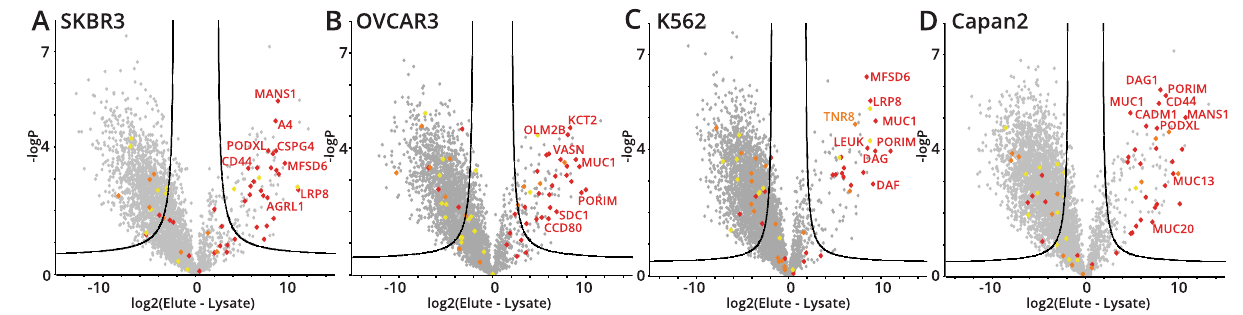
Fig. 3 Mucinome of cancer-associated cell lines. A – D Volcano plots representing four enrichment experiments from SKBR3 ( A ), OVCAR3 ( B ), K562 ( C ), and Capan2 ( D ) cell lines. Cell lysates were subjected to the work fl ow described in Figs. 1 and 2, scored with the mucin-domain candidacy algorithm, and mucin-domain glycoproteins were labeled according to the Mucin Score. Red signi fi ed a score of >2 (high con fi dence), orange 2 – 1.5 (medium con fi dence), and yellow 1.5 – 1.2 (low con fi dence). Strongly enriched proteins were labeled with their gene names associated with speci fi c proteins. Source data are in Supplementary Data 3. Signi fi cance testing was performed using a two-tailed t-test with 250 randomizations to correct for multiple comparisons, an FDR of 0.01, and an S0 value of 2 for all volcano